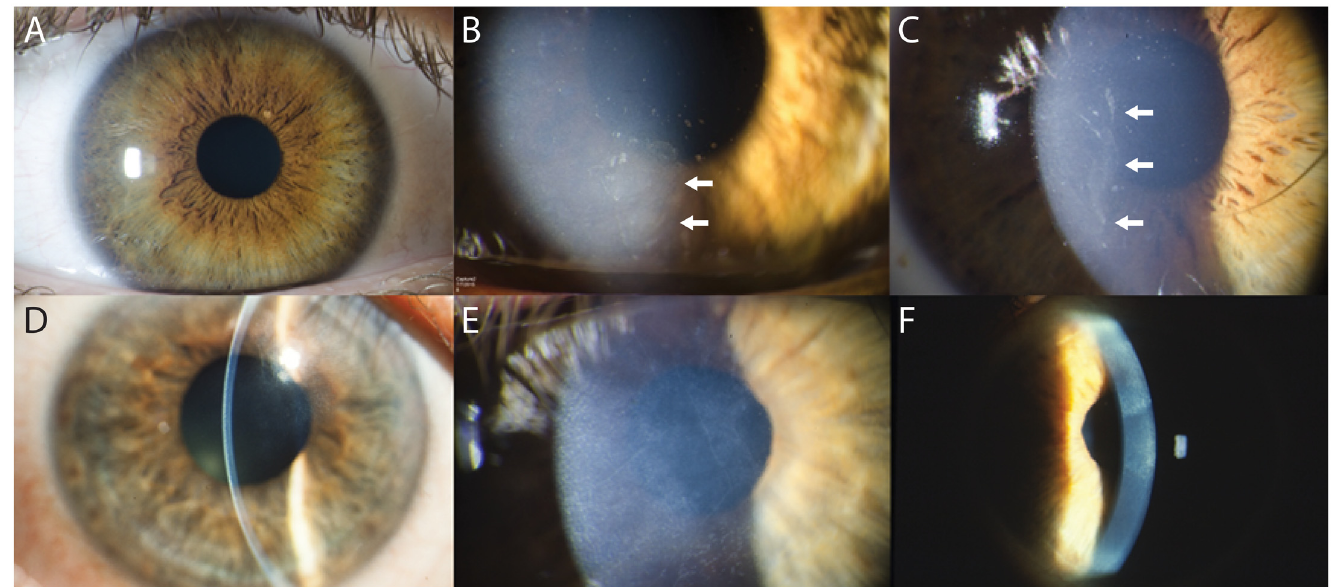
Fig 2. Clinical features of chromosome 10q23-q24 linked dystrophy. A. Affected individual V-2 (28 years old) demonstrates a clear cornea in the right eye. B. Three months later, she developed a corneal erosion (arrows). C. Affected individual V-3 (24 years old) also demonstrated clear corneas prior to the development of a corneal erosion, the location of which can be identified by the opacification of the corneal epithelium (arrows). D. Affected individual IV-1 (72 years old) demonstrates diffuse subepithelial opacification secondary to chronic recurrent corneal erosions seen with slit and diffuse illumination in the right (D and E) and left (F)